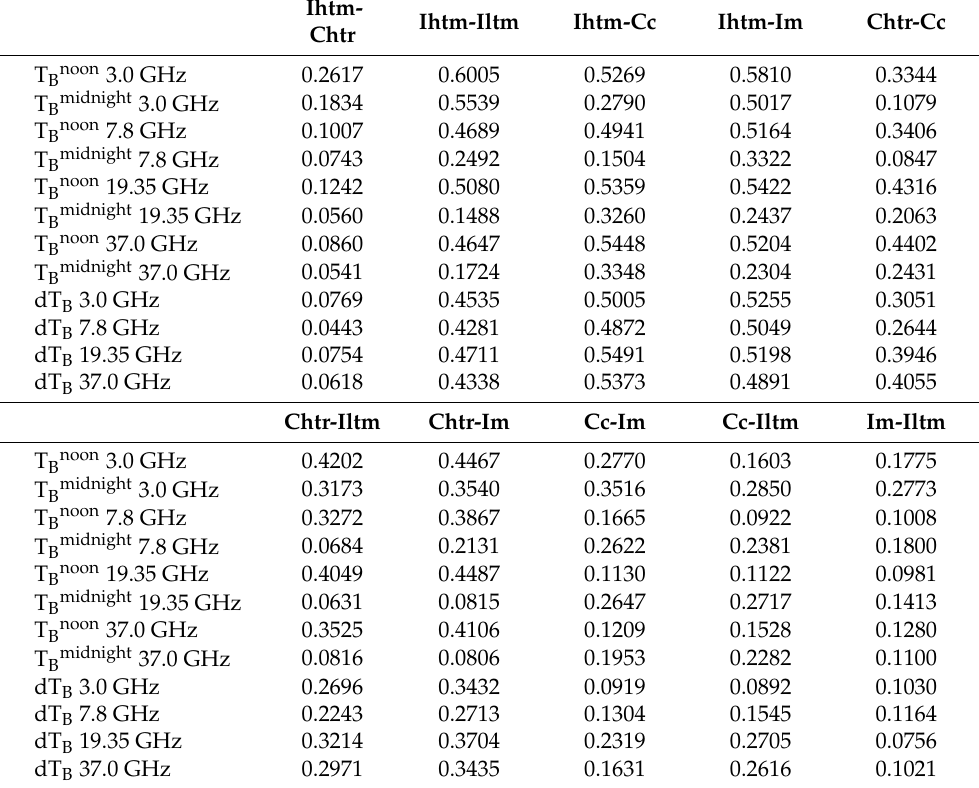
Table 3. ReliefF analysis